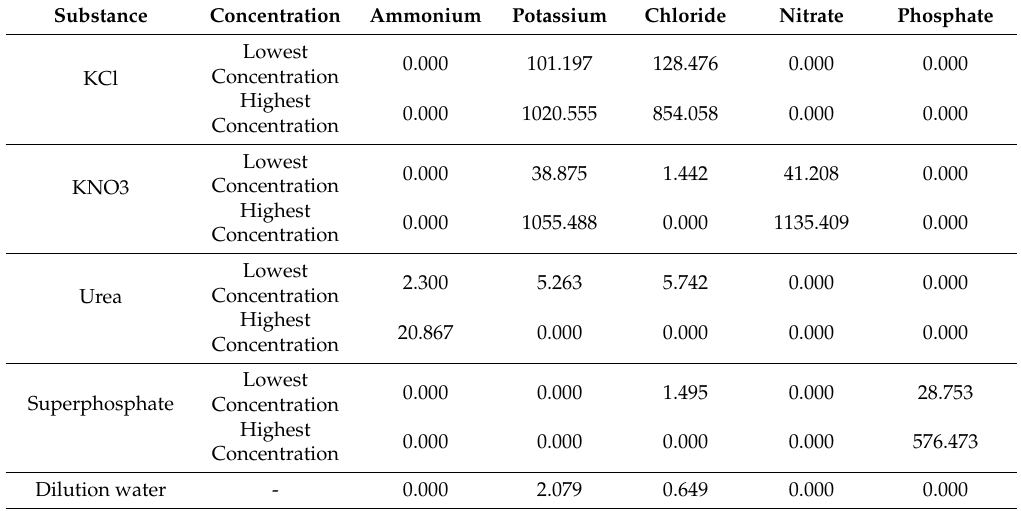
Table 2. Ion chromatography from the dilutions of the commercial fertilizers (units: mg ∙ L − 1 ).